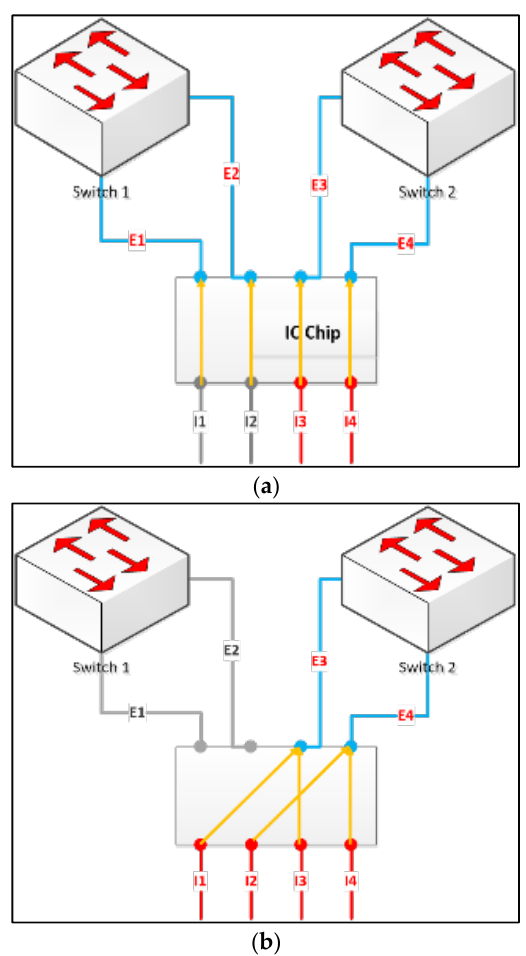
Figure 8. How MUXER can switch data signal from switch 1 to switch 2. ( a ) Before MUXER switches some circuits; ( b ) After MUXER switches some circuits. Technologies 2017 , 5 , 74